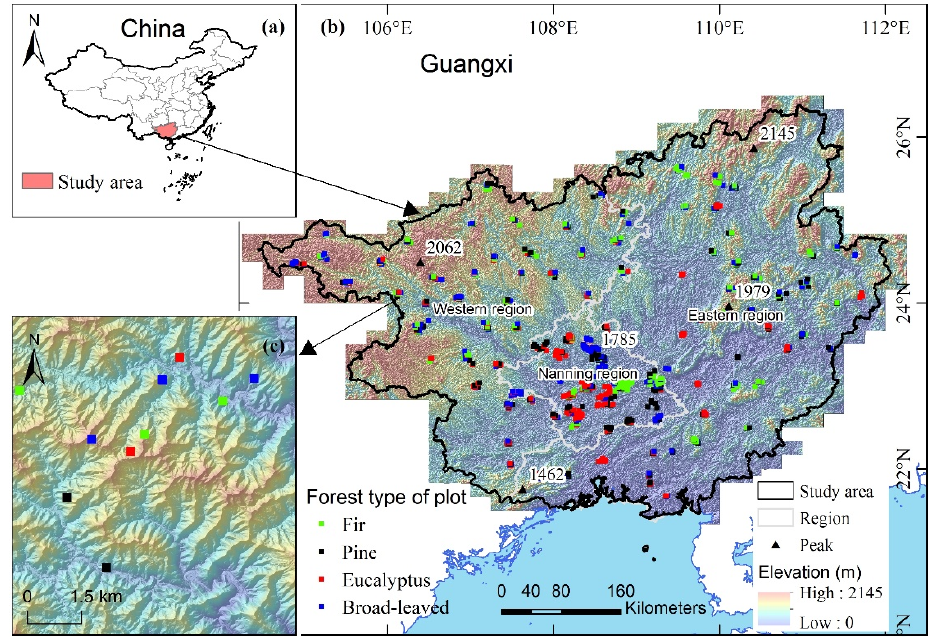
Figure 1. Location of the study area. ( a ) Geographic location of study area in China; ( b ) distribution of field plots in three regions in study area; ( c ) locations of field plots.